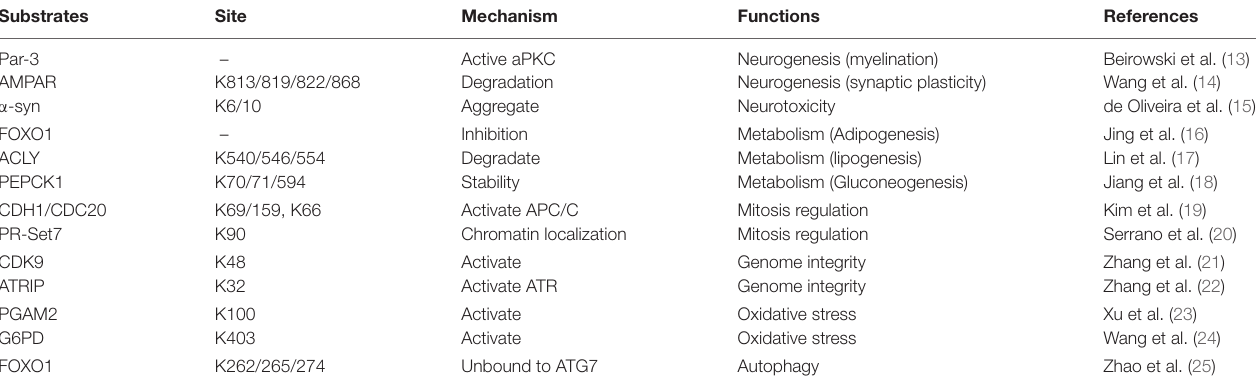
TABLE 1 | The deacetylase substrates of